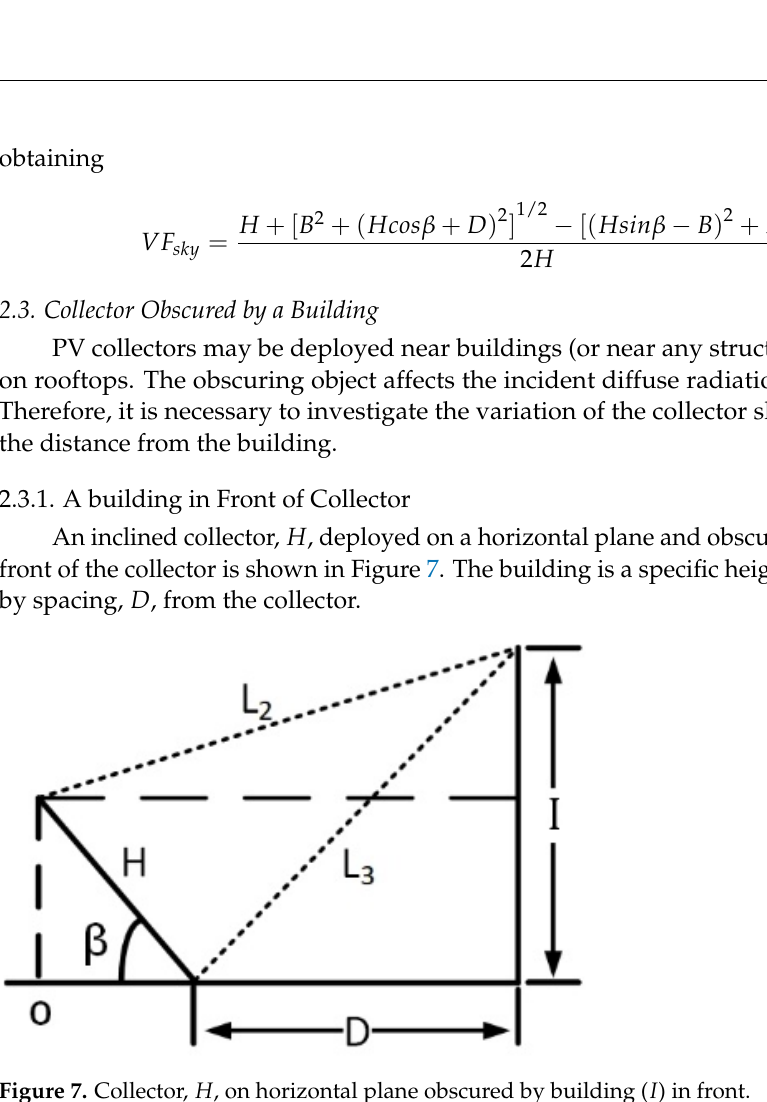
Figure 7. Collector, H , on horizontal plane obscured by building ( I ) in front.